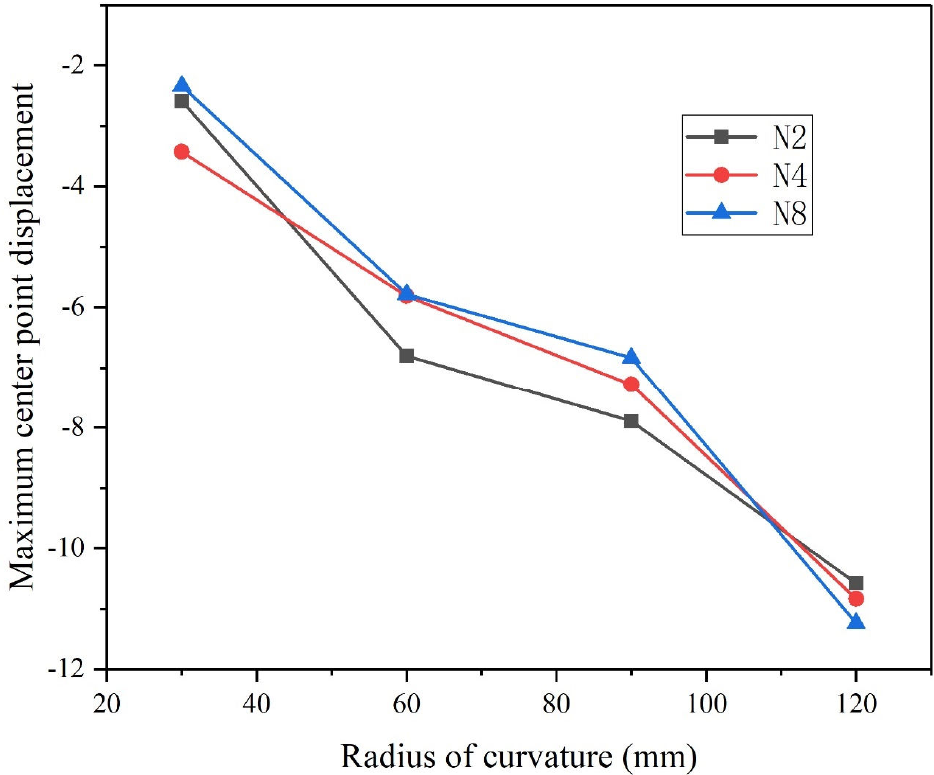
Figure 19. The influence of the number of layers on the maximum deformation of the central point.